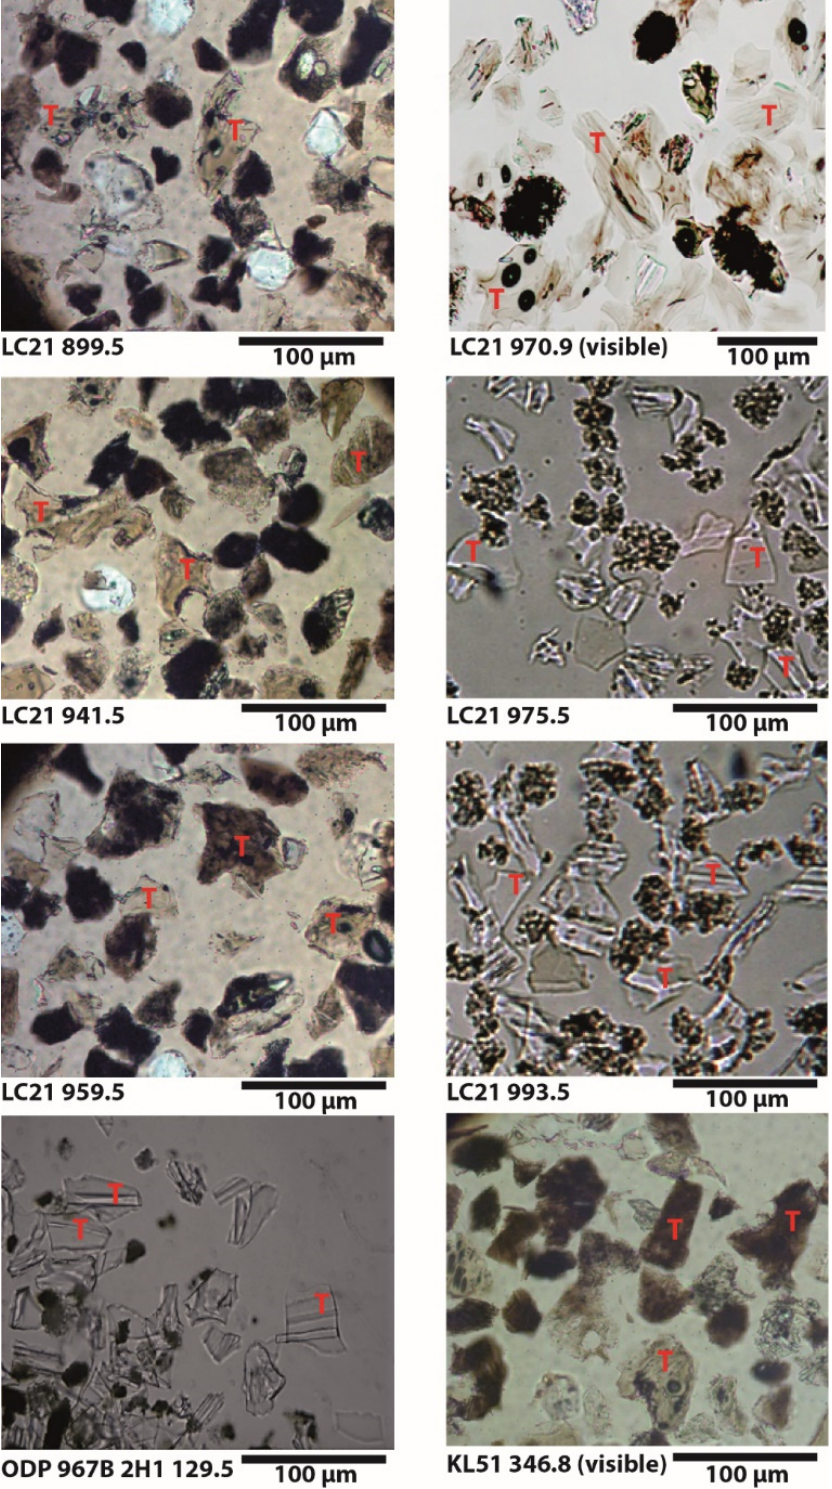
Figure 4. Photomicrographs (transmitted light) of the eight samples of tephra from cores LC21, KL51 and ODP967B. The labels “T” shows good examples of the tephra shards for each sample. See Figure 2 for the stratigraphic position of each sample. The slight blurring around the shards in LC21 975.5 and 993.5 is likely due to the age of the mounting medium in these samples.